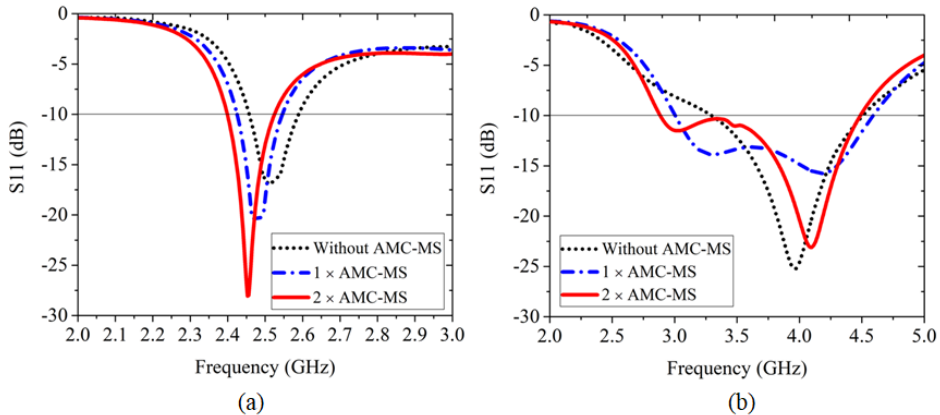
Figure 10. Comparison of S-parameters (S11, dB) without/with the presence of AMC-MS structures (layers) in the proposed antenna configuration for: ( a ) C-mode and ( b )